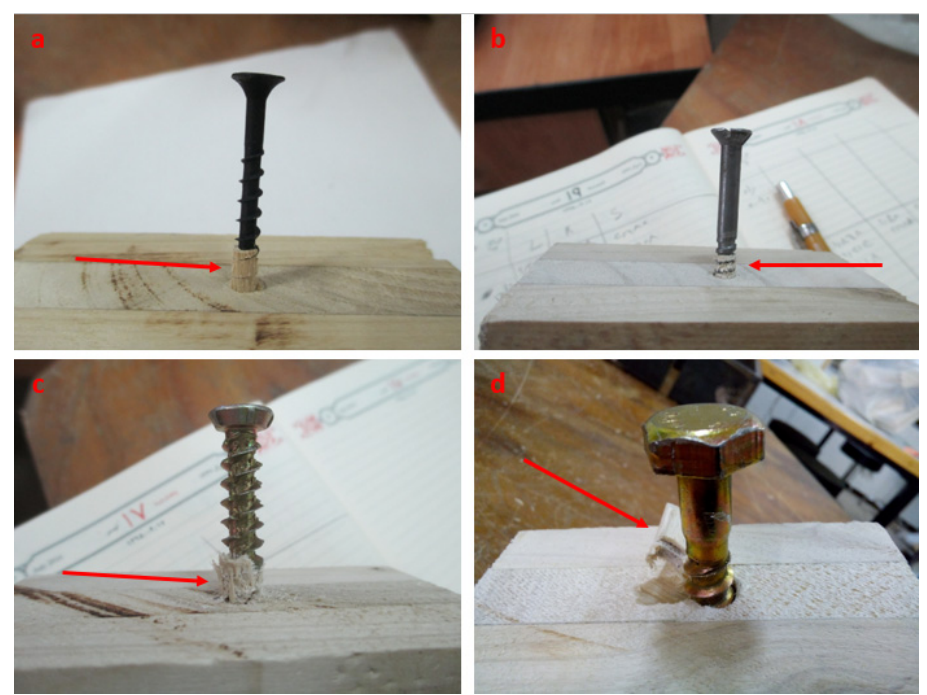
Figure 6. Typical failure modes of CLT members under the withdrawal load parallel to the grains (L direction) . ( a – c ) Column-like pull-out of wood fibers, ( d ) inclined shear failure along with the grains.